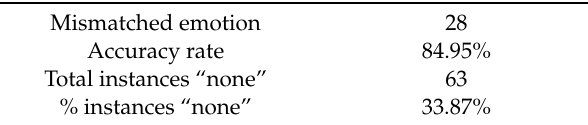
Table 4. Accuracy results for emotion recognition, and instances and percentage for no recognized emotion (“none”) with a native translation instead of IBM Watson’s.